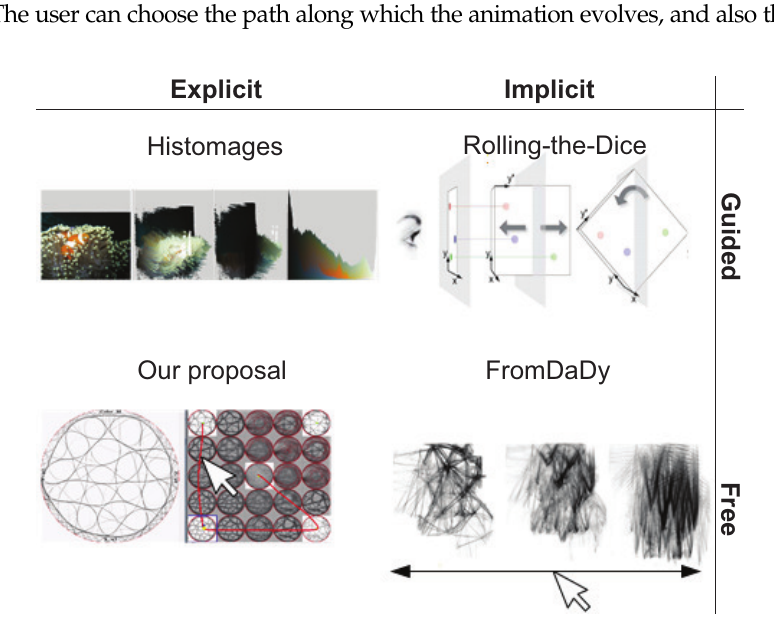
Figure 1. Animation design space between two data views V 1 and V 2 . The user can control or not the transition (controlled vs. automatic), and the transition is defined by the user or predefined by the tool (explicit vs. implicit). The presented tools are Histomages [71], Rolling-the-Dice [39], FromDaDy [58], and our